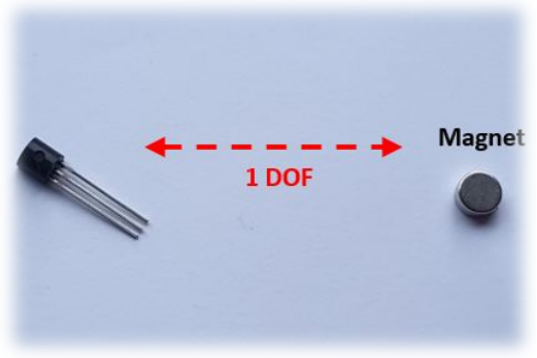
Figure 11. (SS495B) Hall effect